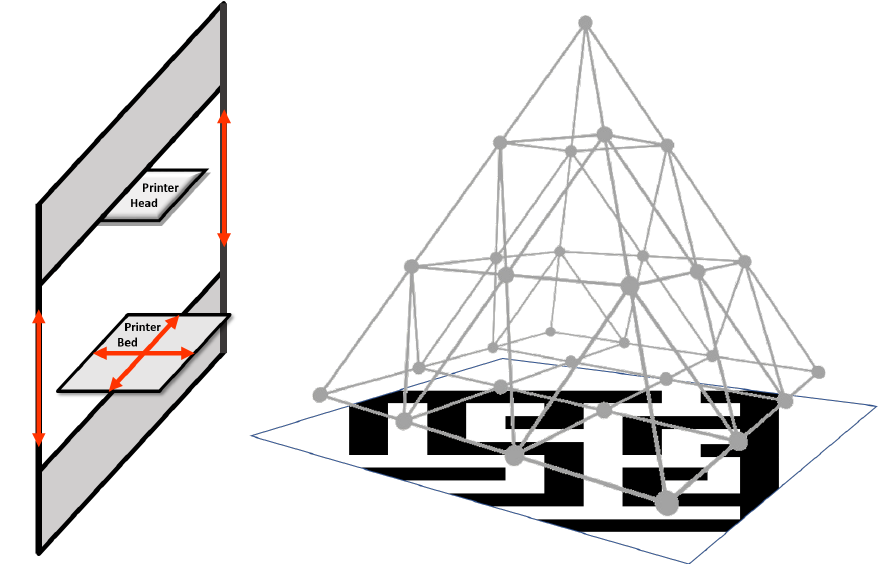
Figure 1. Abstraction of C3Dp motion ( left , recreated from [15]) and proposed scanning locations ( right